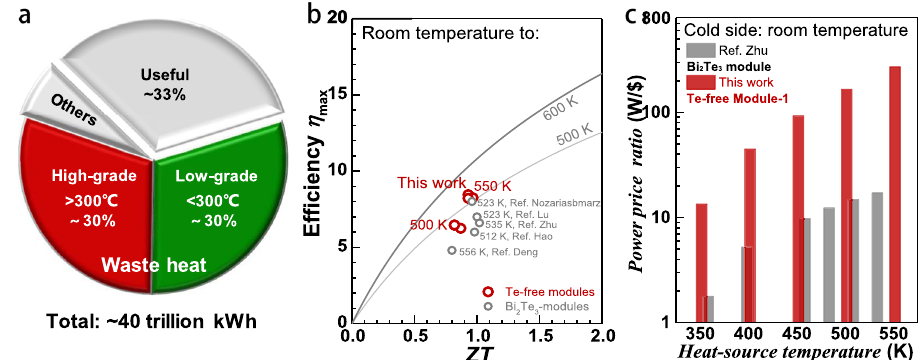
Fig. 1 Energy consumption distribution and thermoelectric performance. Energy consumption distribution indicating the huge proportion of low-grade waste heat ( T < 300 °C) 7,47 ( a ), device ZT dependent maximum ef fi ciency ( η max ) 5,18,48,49 ( b ) and heat-source temperature-dependent power price ratio (W/$) 18 at a conventional leg size of 1.5 × 1.5 × 2 mm 3 for Module – 1 ( c